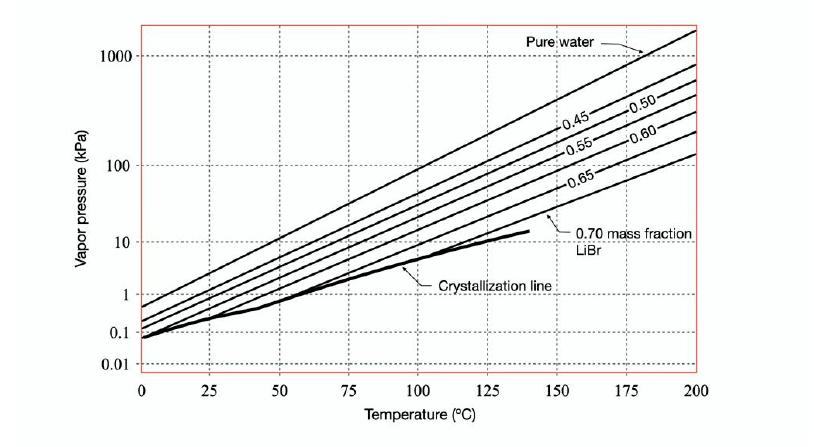
Figure 2. Pressure-temperature diagram for water-lithium bromide [45].